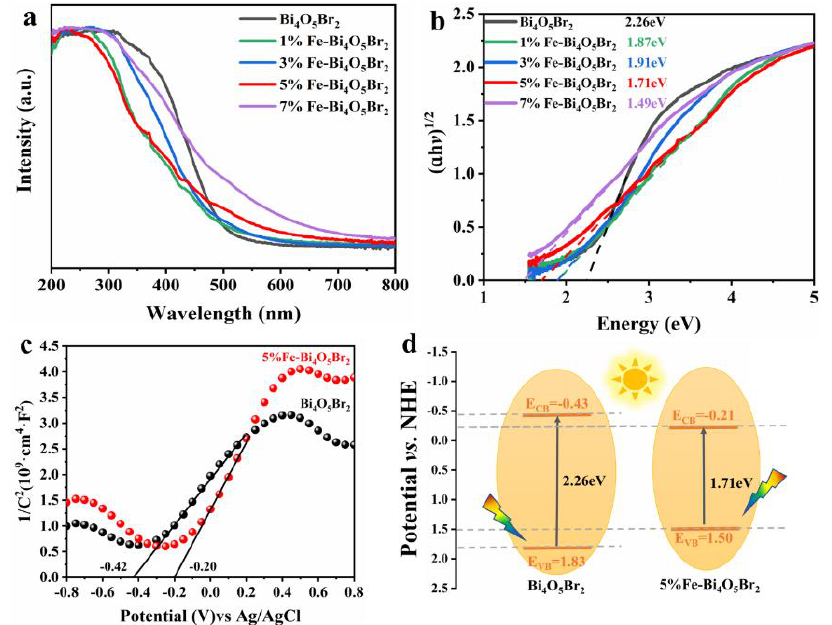
Figure 5. ( a ) UV–vis–NIR DRS spectra, ( b ) Tauc plots, ( c ) Mott-Schottky plots of Bi 4 O 5 Br 2 and 5%Fe-Bi 4 O 5 Br 2 and ( d ) Schematic illustration of band structure over Bi 4 O 5 Br 2 and 5%Fe-Bi 4 O 5 Br 2 .